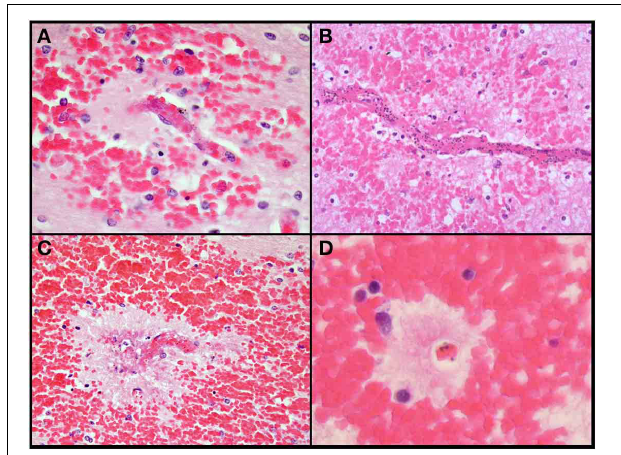
FIGURE 4 | Additional images of ring hemorrhages which highlights the presenceoffibrin(A),parasites(B,C),pigment(A–C),rarifiedbrain(B–D), and variable-sized hemorrhages. All images are originally 600x, H&E.